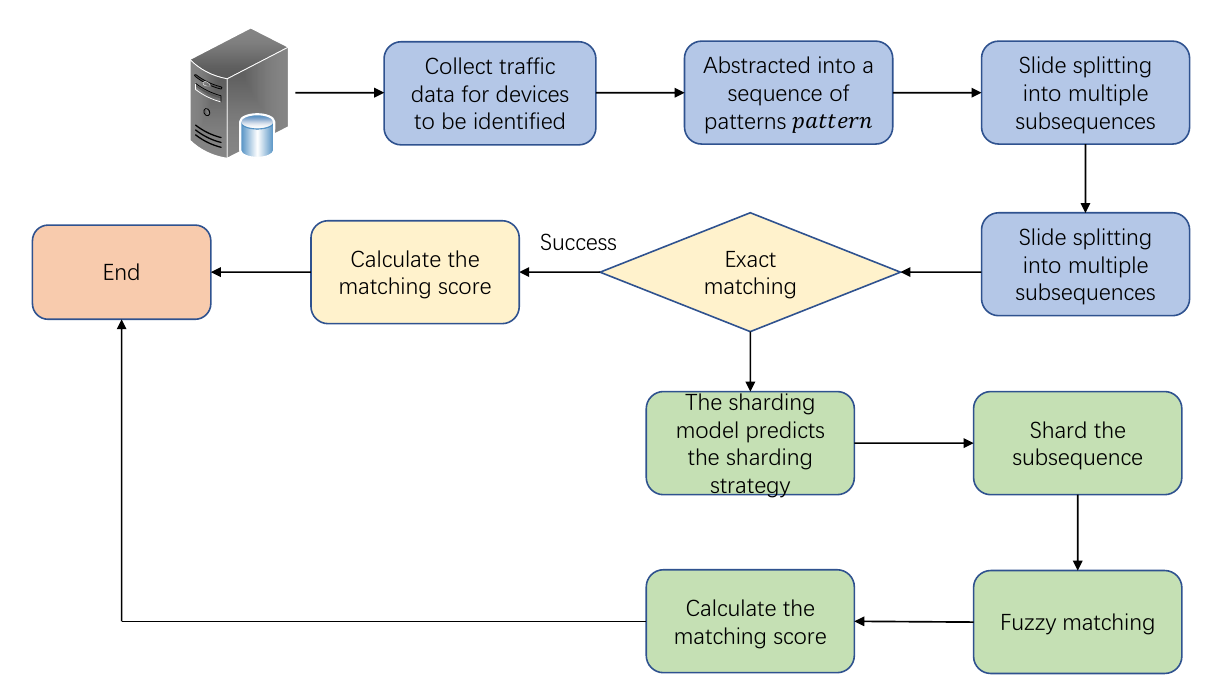
Figure 8. Flow chart of device